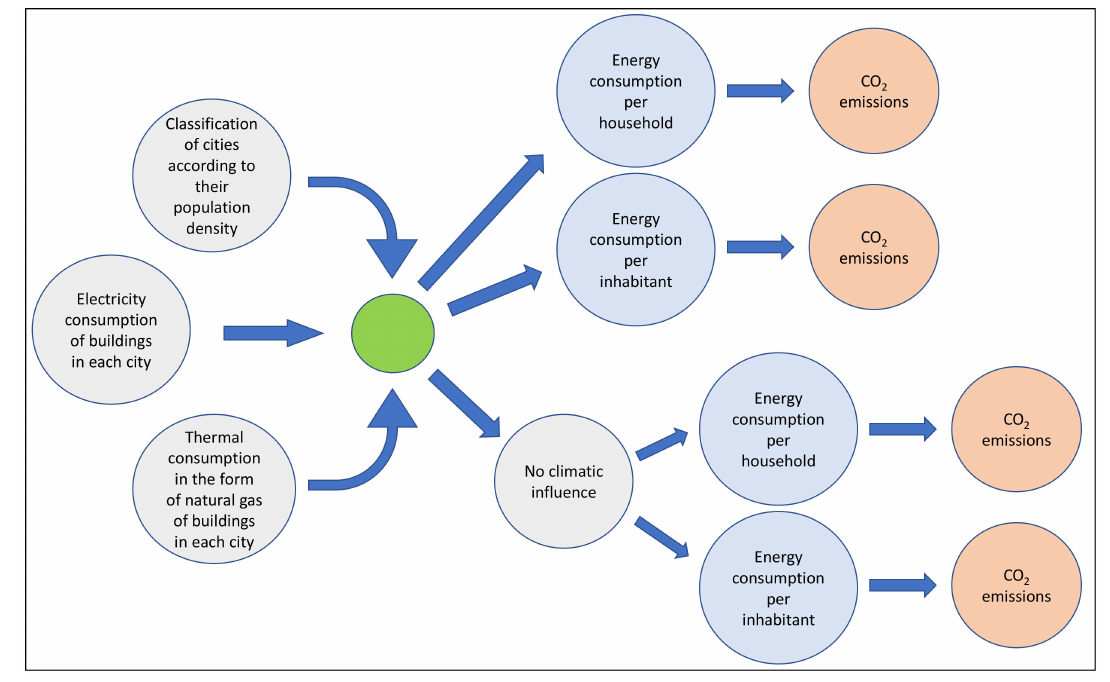
Figure 1. Method